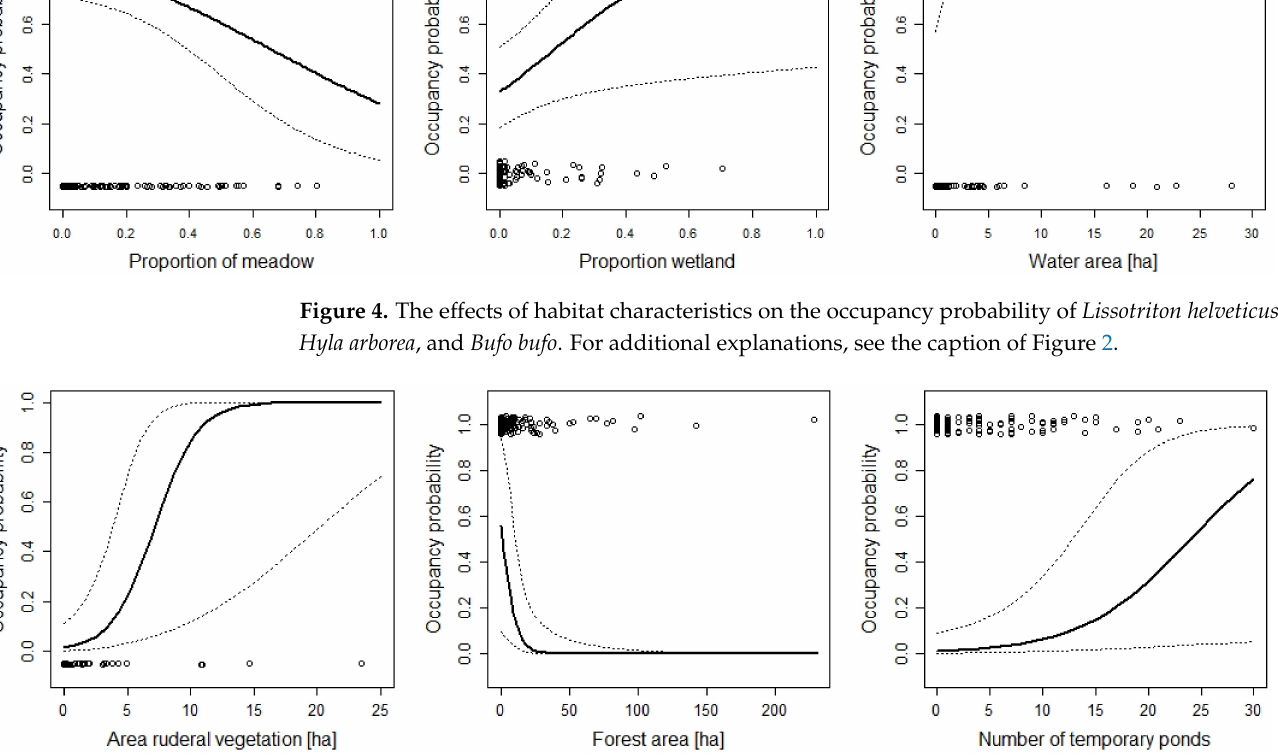
Figure 5. The effect of the area of ruderal vegetation, number of temporary ponds, and forest area on the occupancy probability of Epidalea calamita . For additional explanations, see the caption of Figure 2.